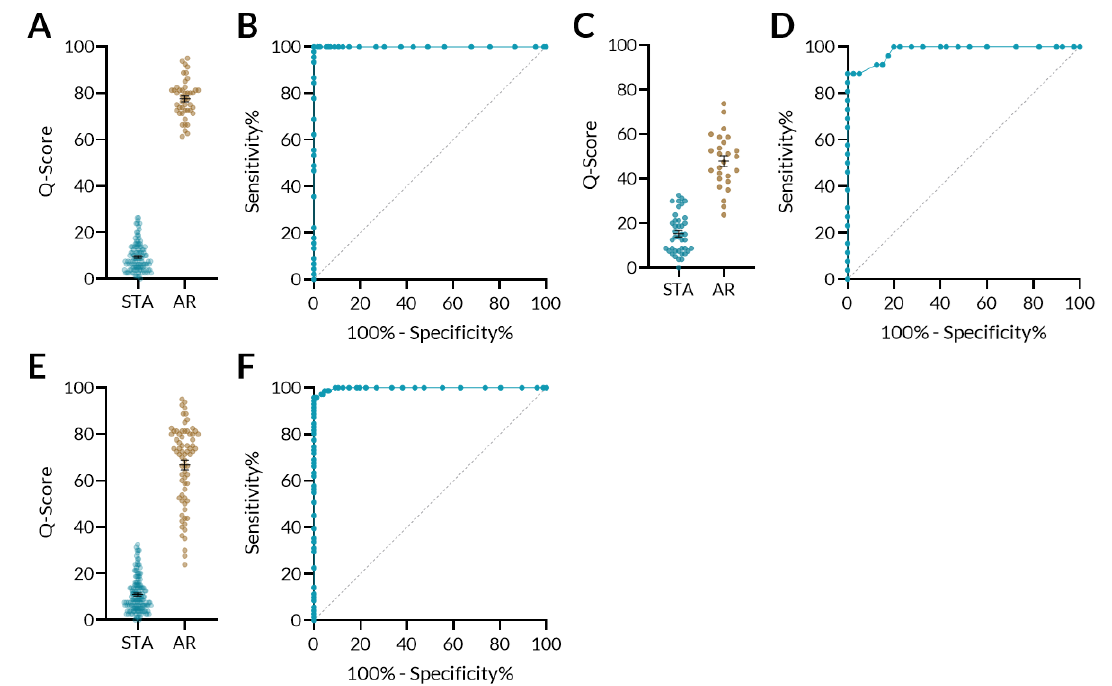
Figure 3. QSant performance: The selected urinary biomarkers could segregate non-rejection patients from those with acute rejection. ( A ) The model was trained on 157 samples consisting of 112 stable transplant allograft (STA) and 45 acute rejection (AR) samples in the training set to generate a scaled score ranging from 0 to 100. At a threshold of 32, the sensitivity was 100% and the specificity was 100%. ( B ) The area under the curve (AUC) of the receiver–operator characteristic (ROC) curve of the training cohort was 100%. ( C ) In the independent validation set, the Q-Score model was applied to a set of 66 independent samples consisting of 40 STA and 26 AR samples. At the pre-determined threshold of 32, the sensitivity was 95.8% (95% CI: 78.9–99.8%) and the specificity was 92.9% (95% CI: 80.5%-98.5%). ( D ) The AUC of the ROC curve of the validation cohort was 98.3% (95% CI: 0.96–1.0). ( E ) At the threshold of 32 for the entire dataset, sensitivity was 95.8% (95% CI: 88.14–99.12%) and specificity was 99.3% (95% CI: 96.4–99.9%). The PPV was 98.0% (95% CI: 87.3–99.7%) and the NPV was 98.6% (95%